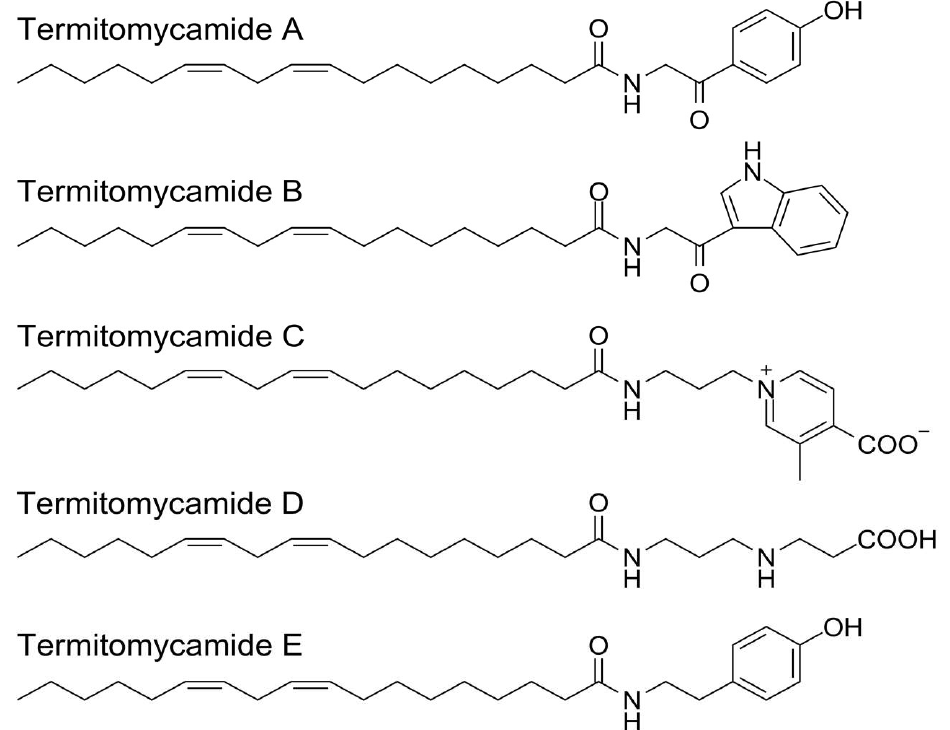
Figure 4. Cerebrosides isolated from T. titanicus (modified from Choi et al. [223]).